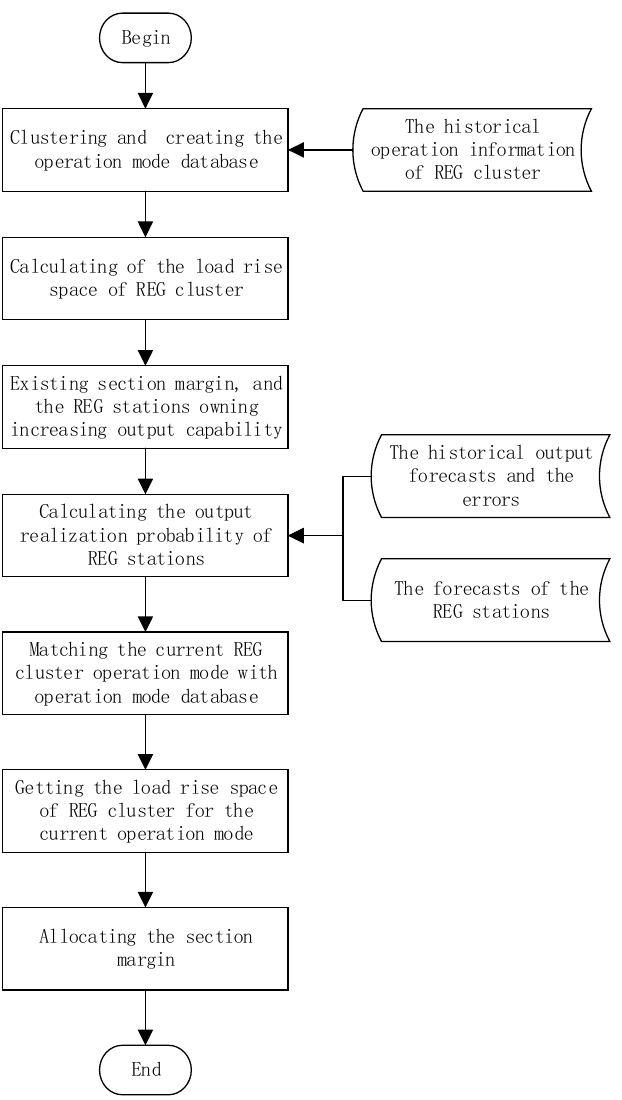
Figure 2. Flow chart of section margin allocation for REG clusters considering the randomness of source and load power. source and load